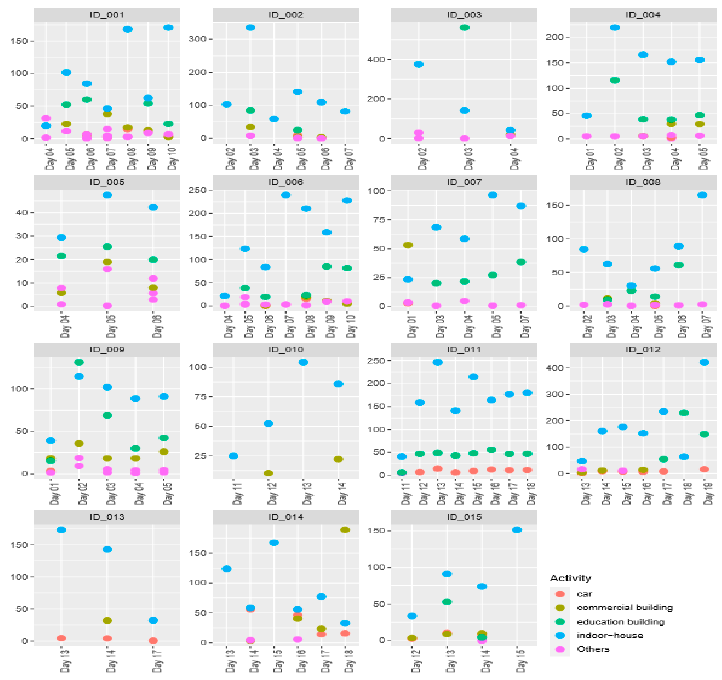
Figure 3. Daily accumulated PM2.5 exposure amount per activity and per person.